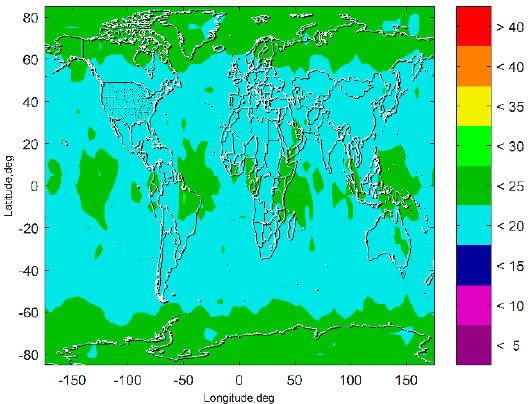
Figure 7. Vertical protection level (VPL) of the subset reduced GNSS alone FD only ARAIM.